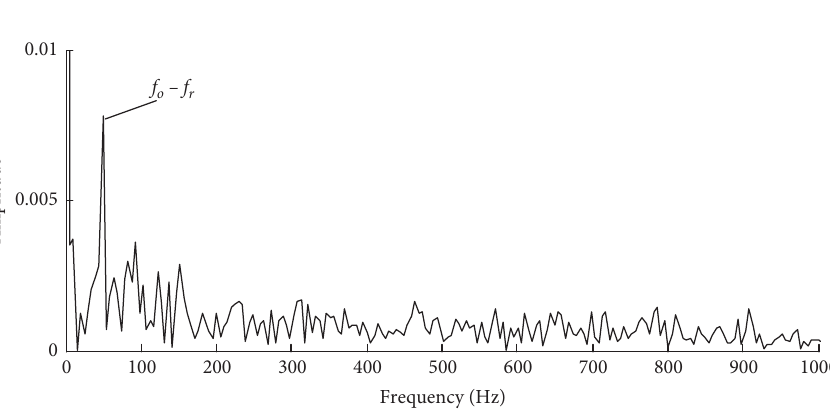
Figure 21: Envelope spectrum of low resonance component of outer race